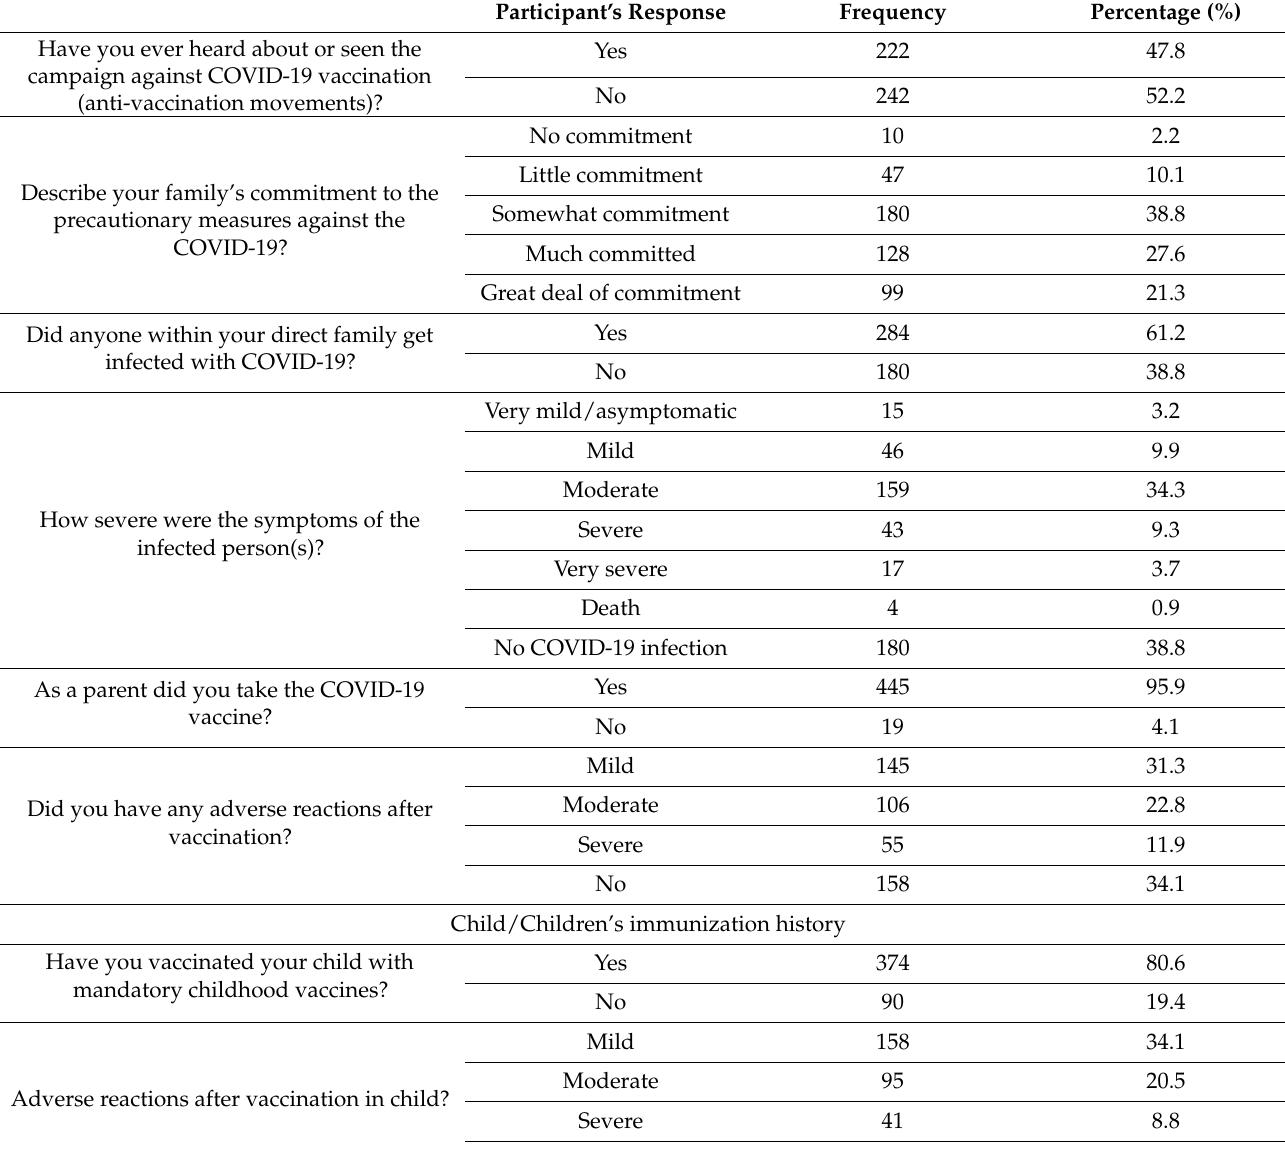
Table 3. Parental behavior, vaccination related to COVID-19, and immunization history of their